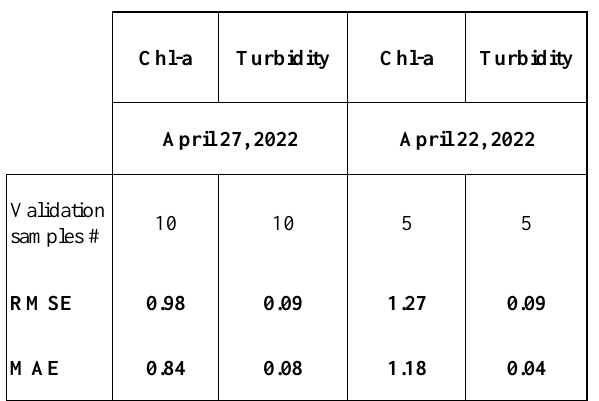
Table 4 . Validation results with in-situ measurements of accepted models applied to two Sentinel-2 test